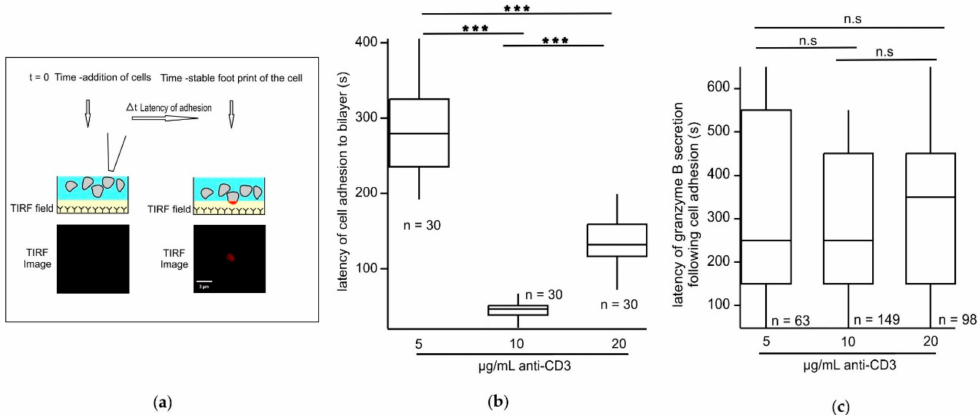
Figure 2. An optimum strength of TCR trigger enables cytotoxic T lymphocytes (CTLs) to adhere significantly faster to stimulatory bilayers. ( a ) Cartoon depicting the experimental strategy to measure latency of adhesion. ( b ) Box plots depicting the latency of cell adhesion to stimulatory bilayers with varied anti-CD3 concentrations. n = number of cells analyzed. ( c ) Box plots depicting the latency of granzyme B secretion normalized to the time of cell adhesion to stimulatory bilayers with varying anti-CD3 concentrations as mentioned in the figure. n = number of vesicles analyzed. *** p < 0.001; ns, non-significant ( p >